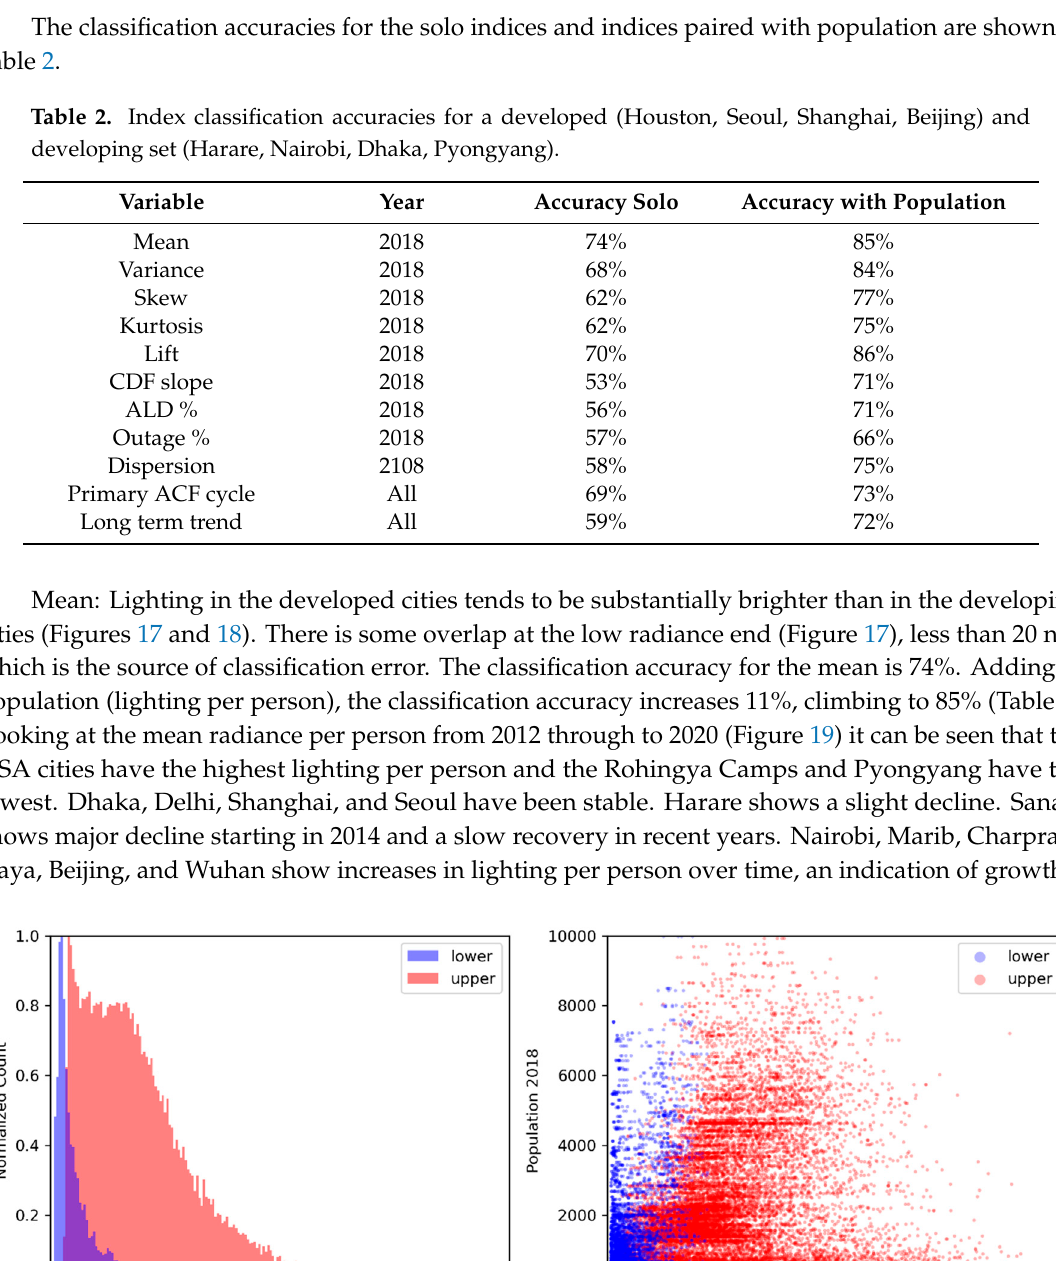
Figure 18. Picket-fence chart of the mean radiances for each of the test sites by year.